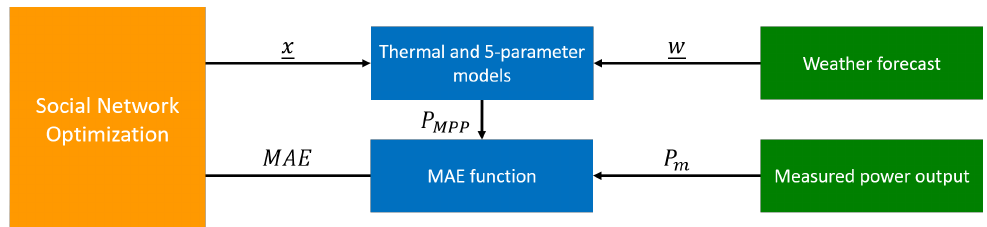
Figure 2. Scheme of the matching procedure with Social Network Optimization.